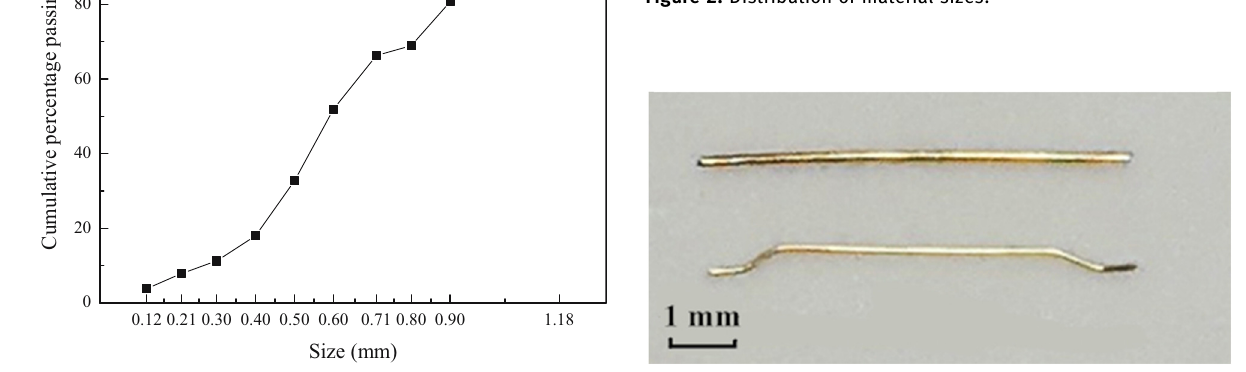
Figure 2: Distribution of material sizes.